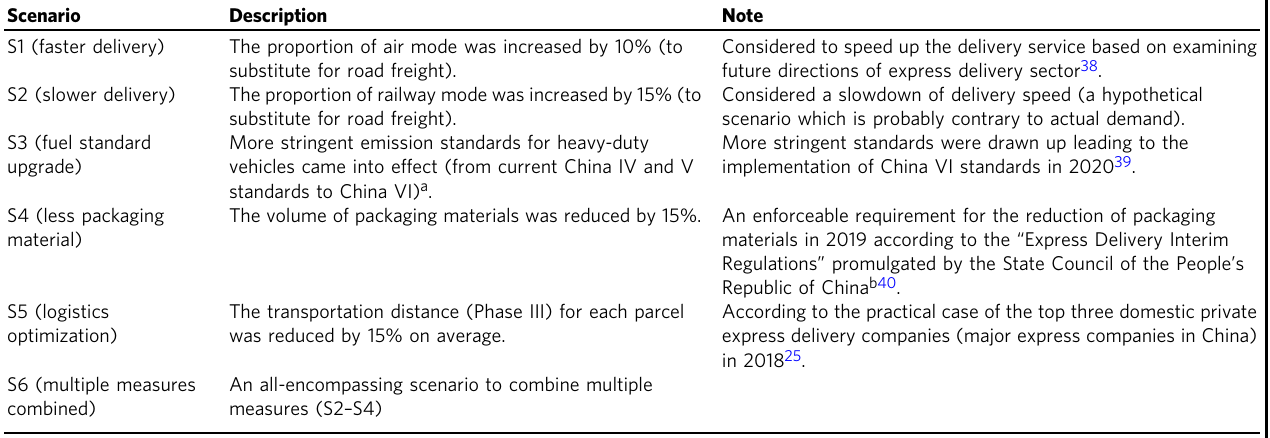
Table 2 Scenarios for future projection of express delivery in